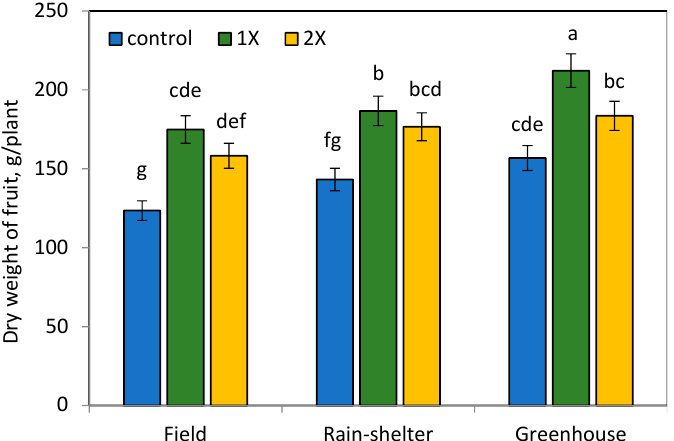
Figure 1. Dry weight of fruit per plant (g) at 130 DAT. Means separated by same lower case letter in each column are not significantly di ff erent at p < 0.05 among treatments.